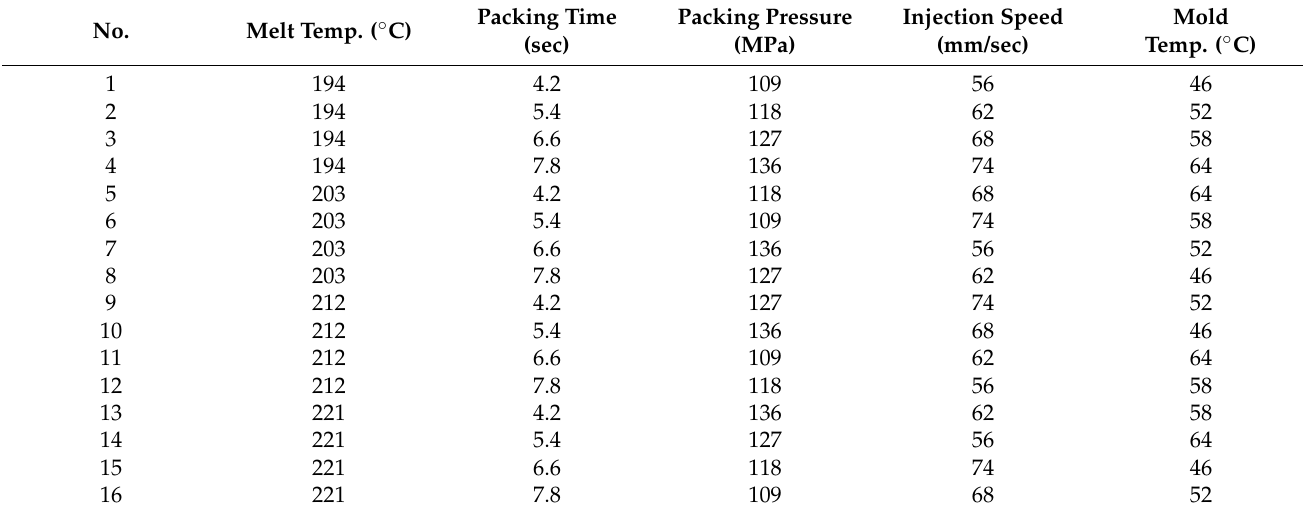
Table 19. Validation data for the round plate model (EXP-16).